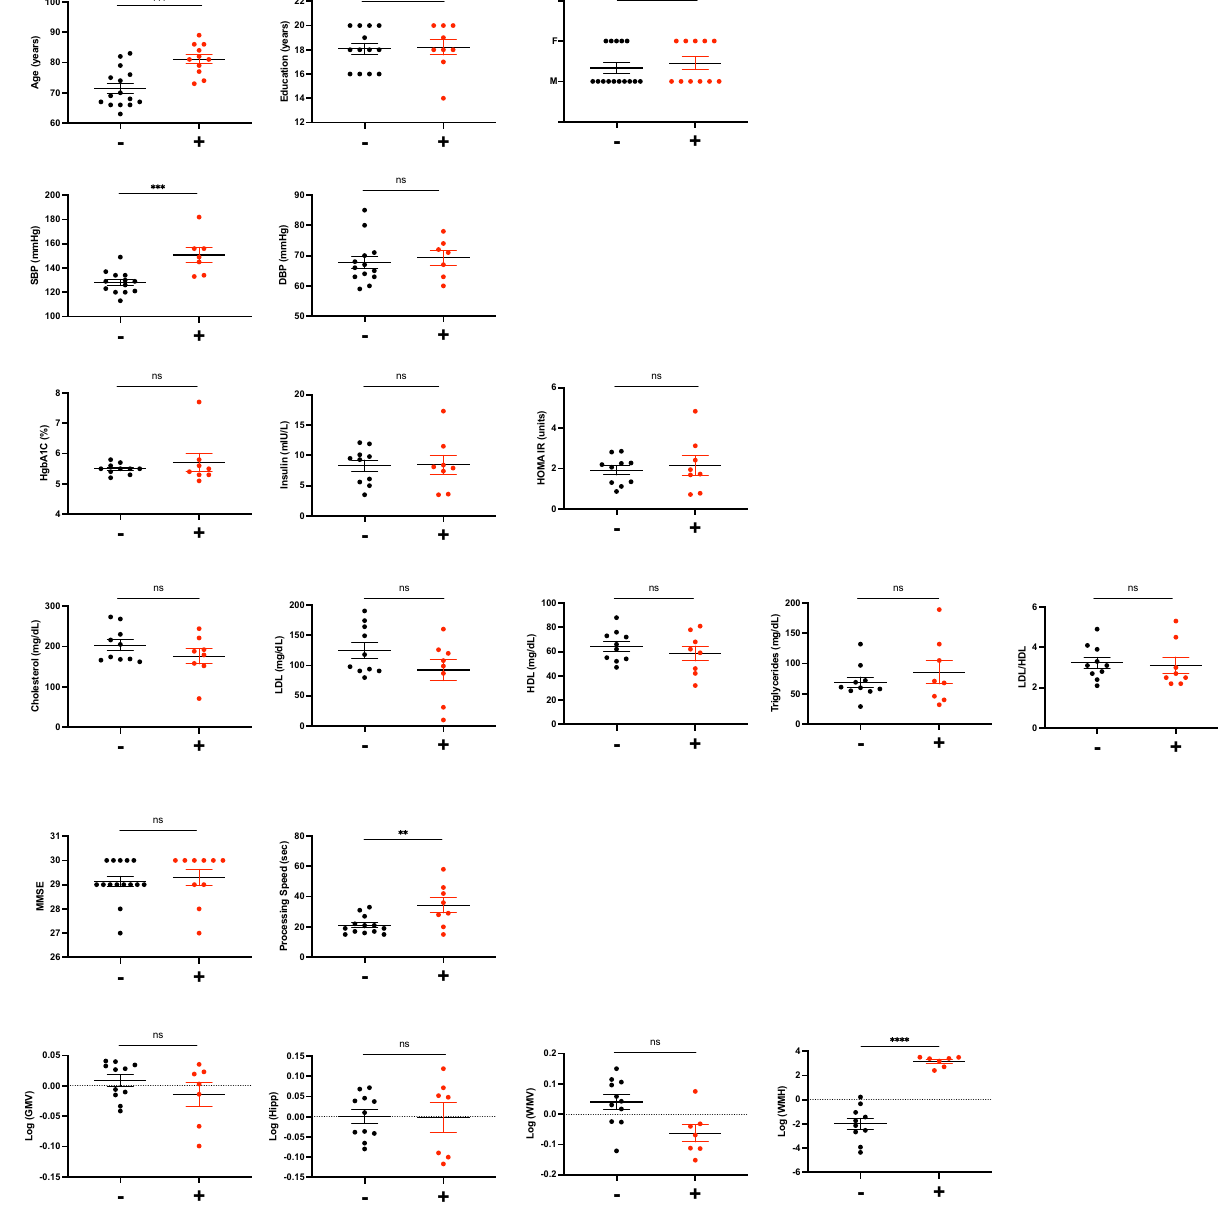
Figure 1. Demographic, cognitive and vascular risk group comparisons between subjects with WMH and without. Demographics include age, gender, and education; vascular risk factors include systolic and diastolic blood pressure, as well as clinical labs: hemoglobin A1C, insulin, homeostatic model assessment of insulin resistance, total cholesterol, low density lipoprotein, ratio of low to high density lipoprotein, and triglycerides; neuroimaing: white matter hyperintensity, global white matter volumes, global grey matter volumes, and mean of bilateral hippocampal volumes. For volumetric neuroimaging measures, total intracranial volumes were regressed out and residual used in models. Dependent variables were log transformed as needed to approximate normal distributions. All significance levels are from ANCOVA for continuous variables controlling for age, and Chi-square for gender. The graphs show plots of raw values, however the significance of statistical models are for ANCOVA models. The dissociation between statistical models built with age-adjusted versus un-adjusted values is most notable for WMV in this figure. SBP systolic blood pressure; DBP diastolic blood pressure; HgbA1c hemoglobin A1C; HOMA-IR homeostatic model assessment of insulin resistance; LDL low density lipoprotein; HDL high density lipoprotein; MMSE mini-mental status examination; WMH white matter hyperintensity; WMV white matter volume; GMV grey matter volume. Stars depict p-value significance levels from Student’s t tests: ****; ≤ 0.001 = ***; ≤ 0.01 = **; ≤ 0.05 = *; ≥ 0.05 =